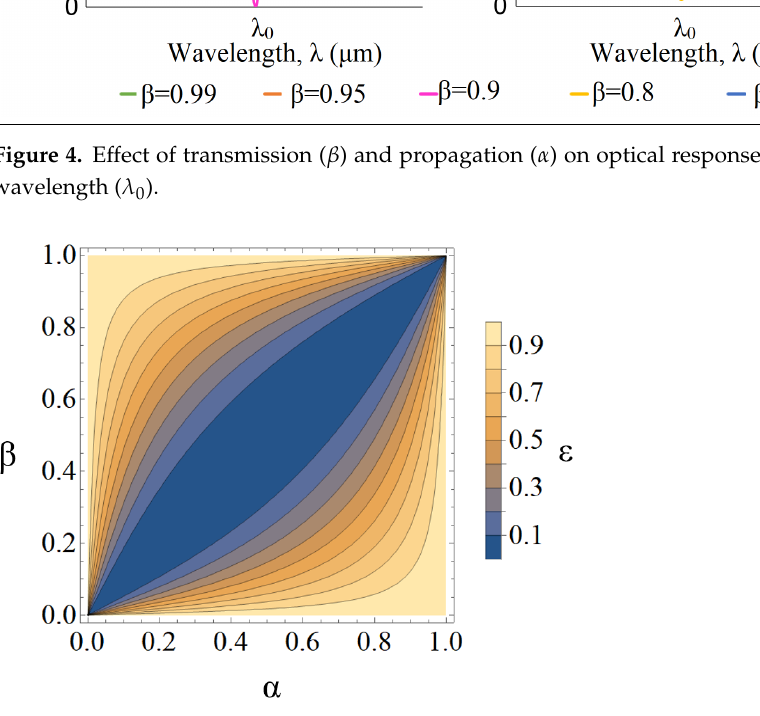
Figure 5. Variation of the transmission ratio (cid:101) (Equation (21)) at the resonant wavelength ( λ 0 ) as propagation ( α ) and transmission ( β ) parameters change for an RCSS microresonator; (cid:101) = 0 (ideal) when α = β